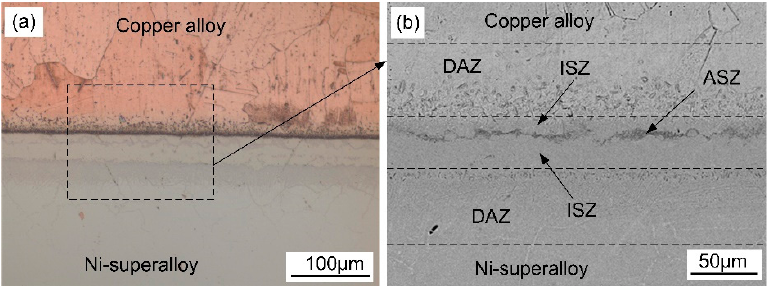
Figure 3. Optical ( a ) and SEM-BSE ( b ) micrographs of copper/superalloy interface in a TLP-bonded sample made at 1030 °C for 60 min.